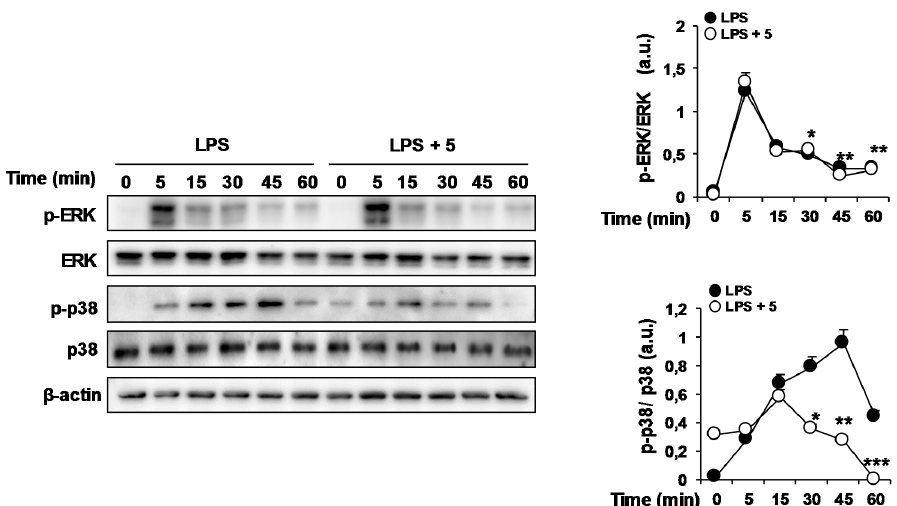
Figure 7. Regulation of MAPK activities by diterpene 5 . Macrophages were pretreated for 30 min with compound 5 (20 µM) and then activated for the indicated times (5, 15, 30, 45, and 60 min) with 200 ng/mL LPS. Levels of phospho- and total MAPKs (ERK and p38) were determined by Western blot. A representative experiment is shown. Densitometry analysis shows the mean ± SD of three independent Western blot experiments. * p < 0.05, ** p < 0.01, and *** p < 0.001 vs, LPS.